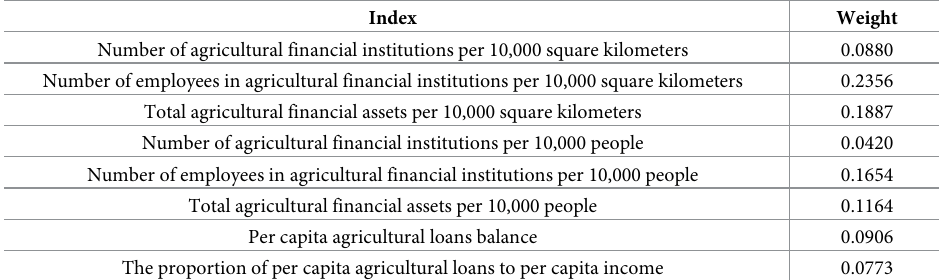
Table 2. The weight of third-level indices of farmland financial